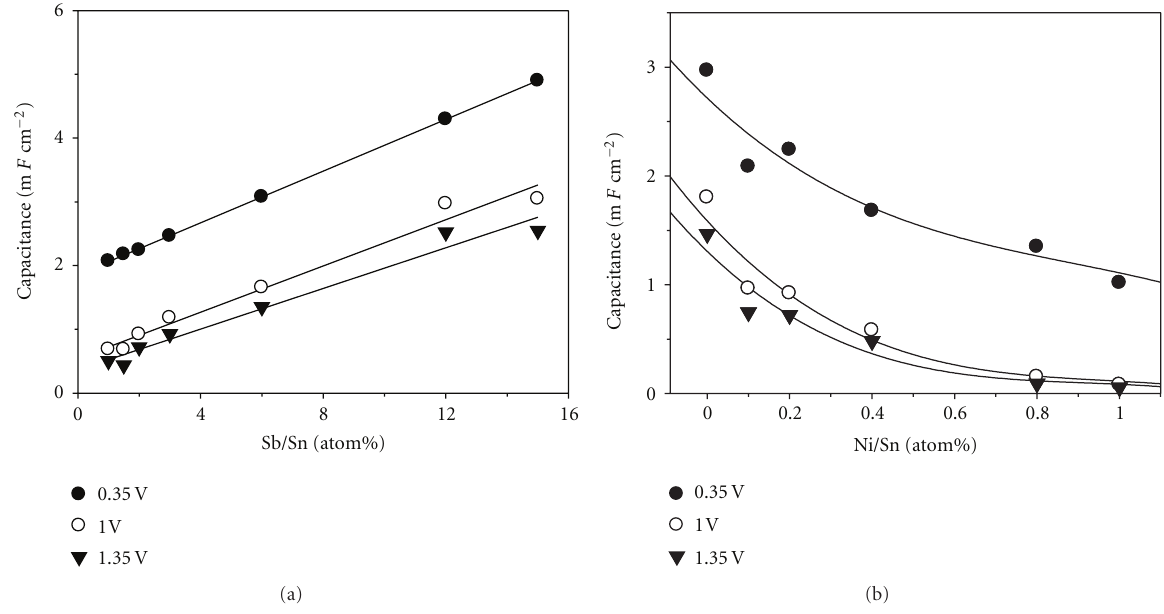
Figure 4: The e ff ect of (a) Sb concentration in Ti / SnO 2 -Sb( x %)-Ni(0.2%) and (b) Ni concentration in Ti / SnO 2 -Sb(2%)-Ni( x %) electrodes on the values of capacitance at 0.35, 1.00, and 1.35 V. The values in the parentheses are atomic ratios with respect to